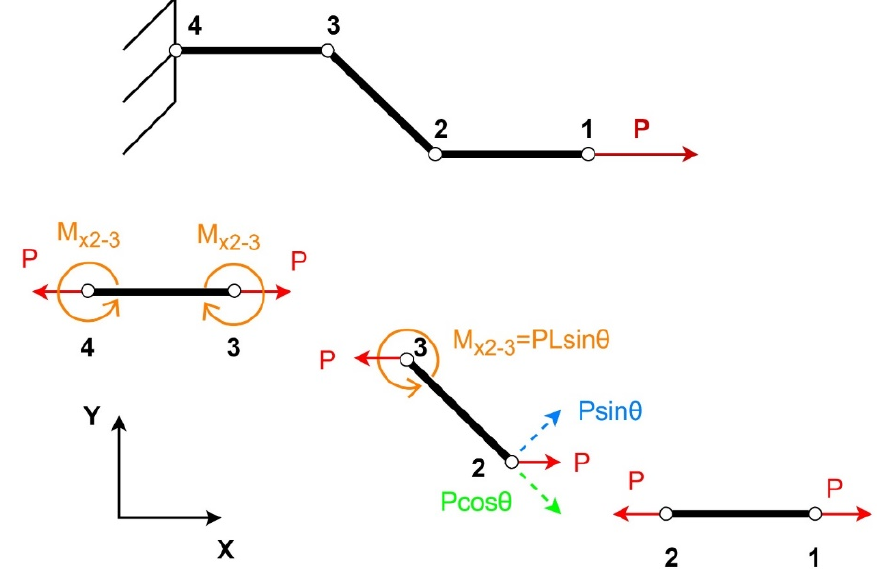
Figure 2. Free body diagram for loading in the x-direction.